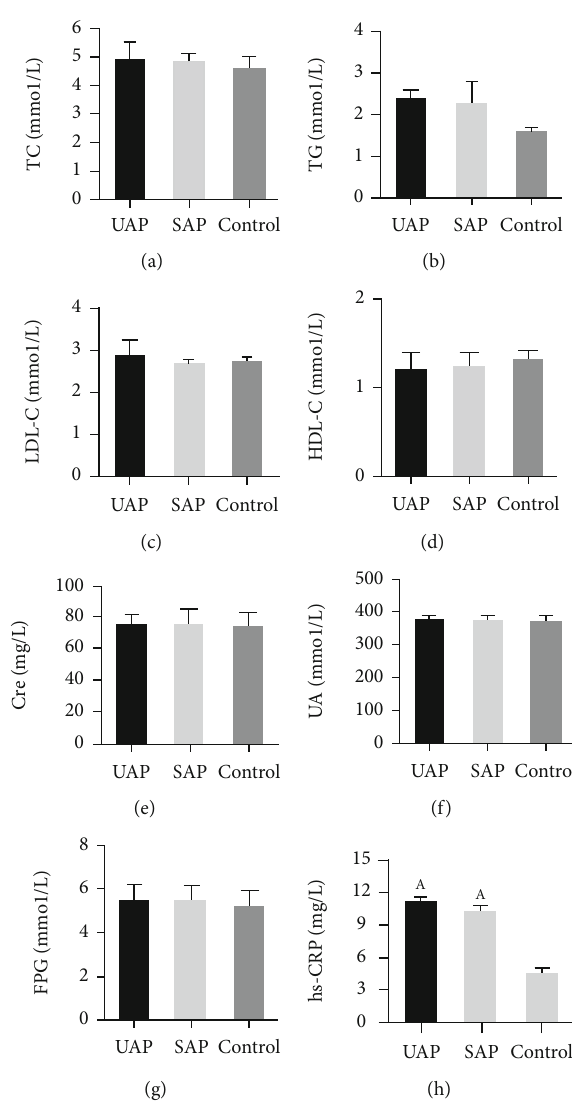
Figure 1: Comparison on blood routine indicators of patients in di ff erent groups. (a – h) The comparisons on TC, TG, LDL-C, HDL-C, Cre, UA, and hs-CRP, respectively, A suggested P < 0 : 05 to the values of